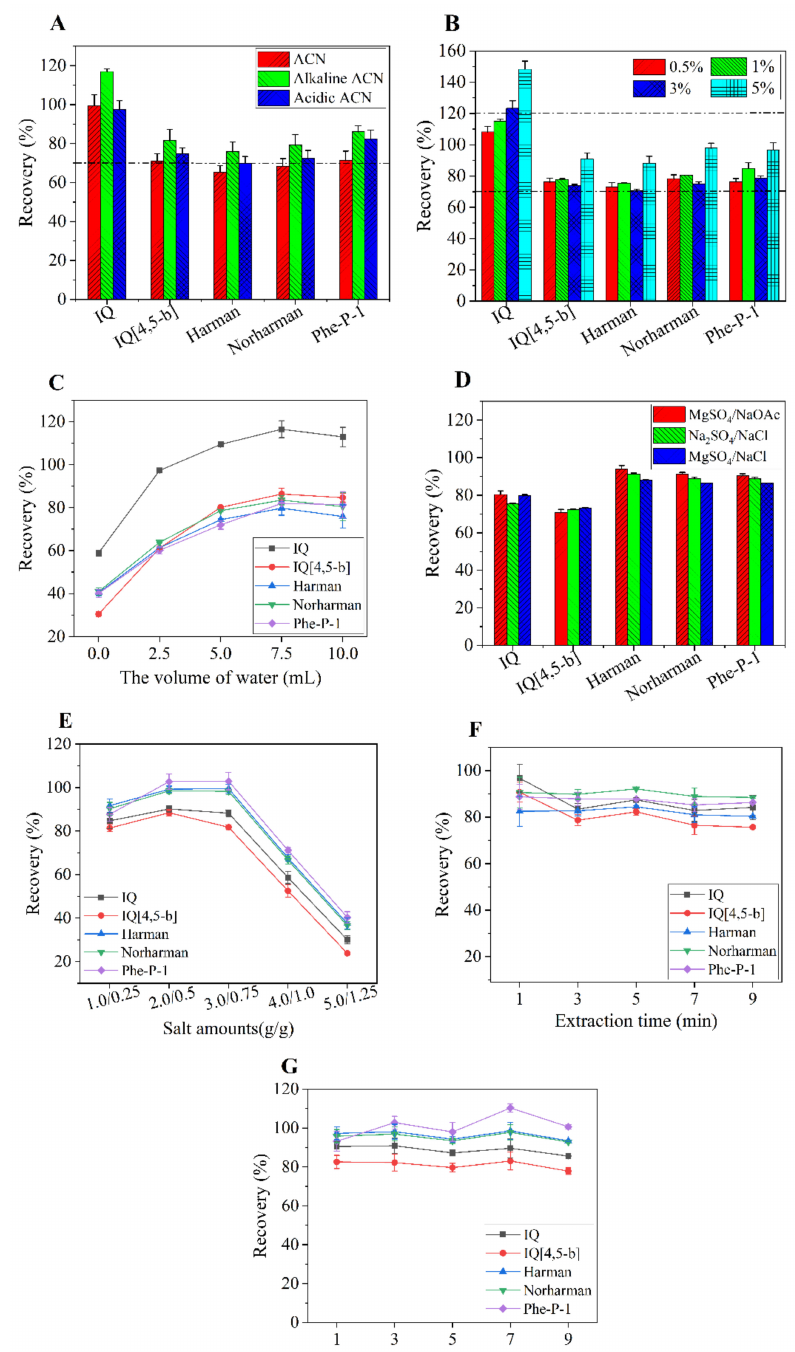
Figure 1. Effects of experimental conditions of the extraction process on the recovery. ( A ): acetonitrile, alkaline acetonitrile and acidic acetonitrile; ( B ): different percentages of ammonium hydroxide in acetonitrile; ( C ): volume of water; ( D ): type of extraction salt; ( E ): amount of MgSO 4 /NaOAc; ( F ): extraction time; ( G ): centrifugation time. Spiked concentration, 300